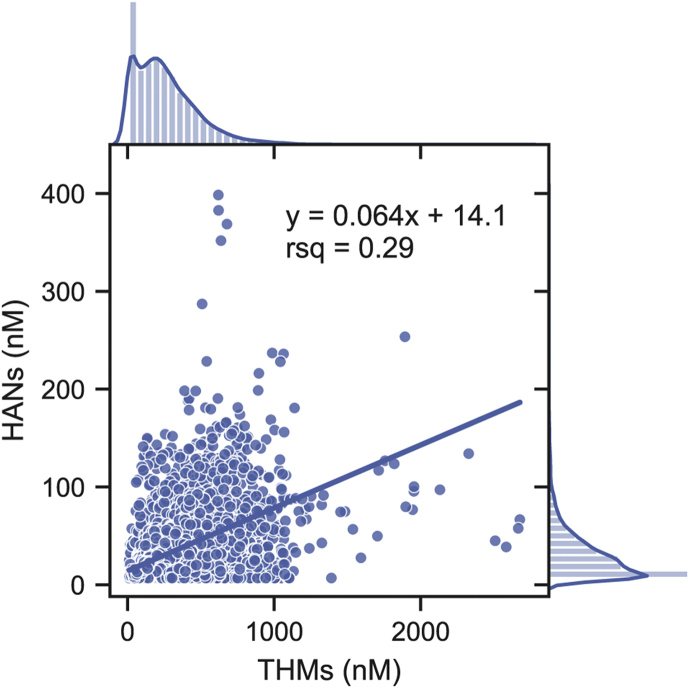
Scatter plot (center) and distributions (margins) of THM and HAN nM concentrations measured in finished effluent and distribution system samples (n = 9587). The OLS line of best fit is y = 0.064x + 14.1 (μg/L: y = 0.066x + 1.8) with Pearson’s correlation coefficient (r2) of 0.29 (μg/L: 0.31).